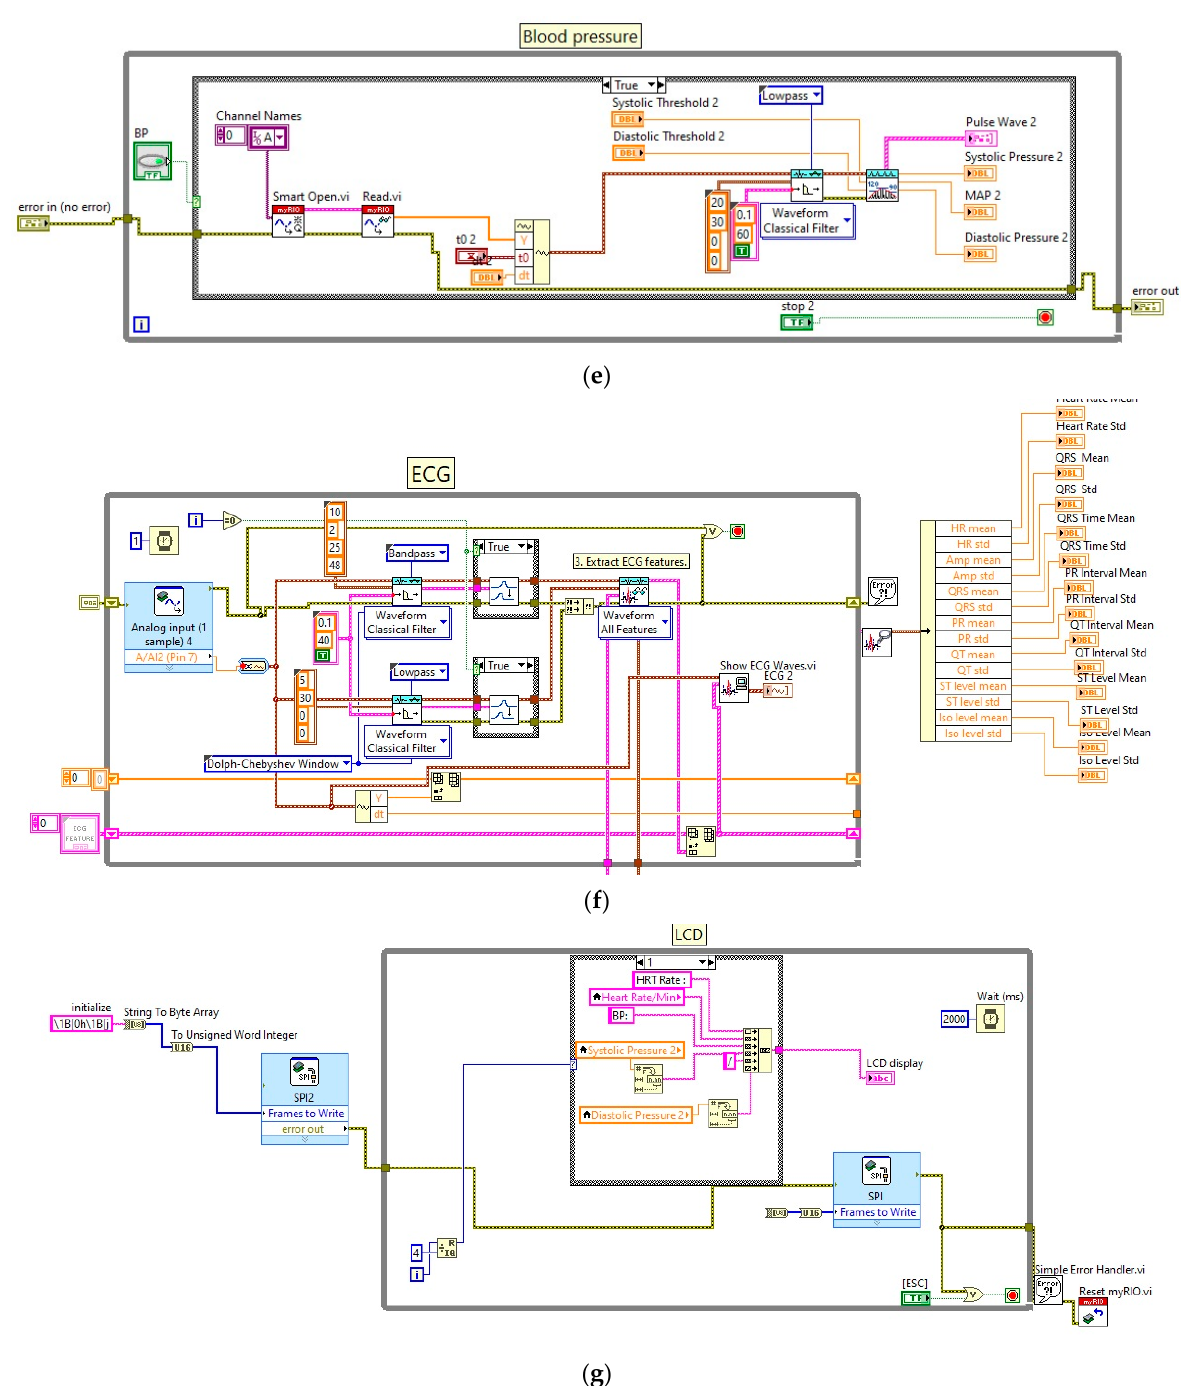
Figure 7 . LabVIEW block diagram code for ( a ) webcam interface; ( b ) body temperature measurement; ( c ) PPG-based heart rate measurement; ( d ) thermistor-based breathing rate measurement; ( e ) blood pressure measurement; ( f ) ECG measurement; ( g ) SPI-based LCD interface .